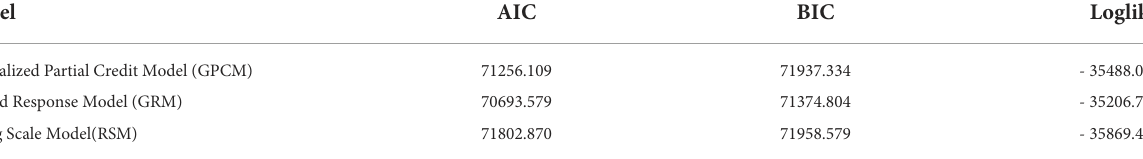
TABLE 2 Estimate item response theory (IRT) model relative fit index.